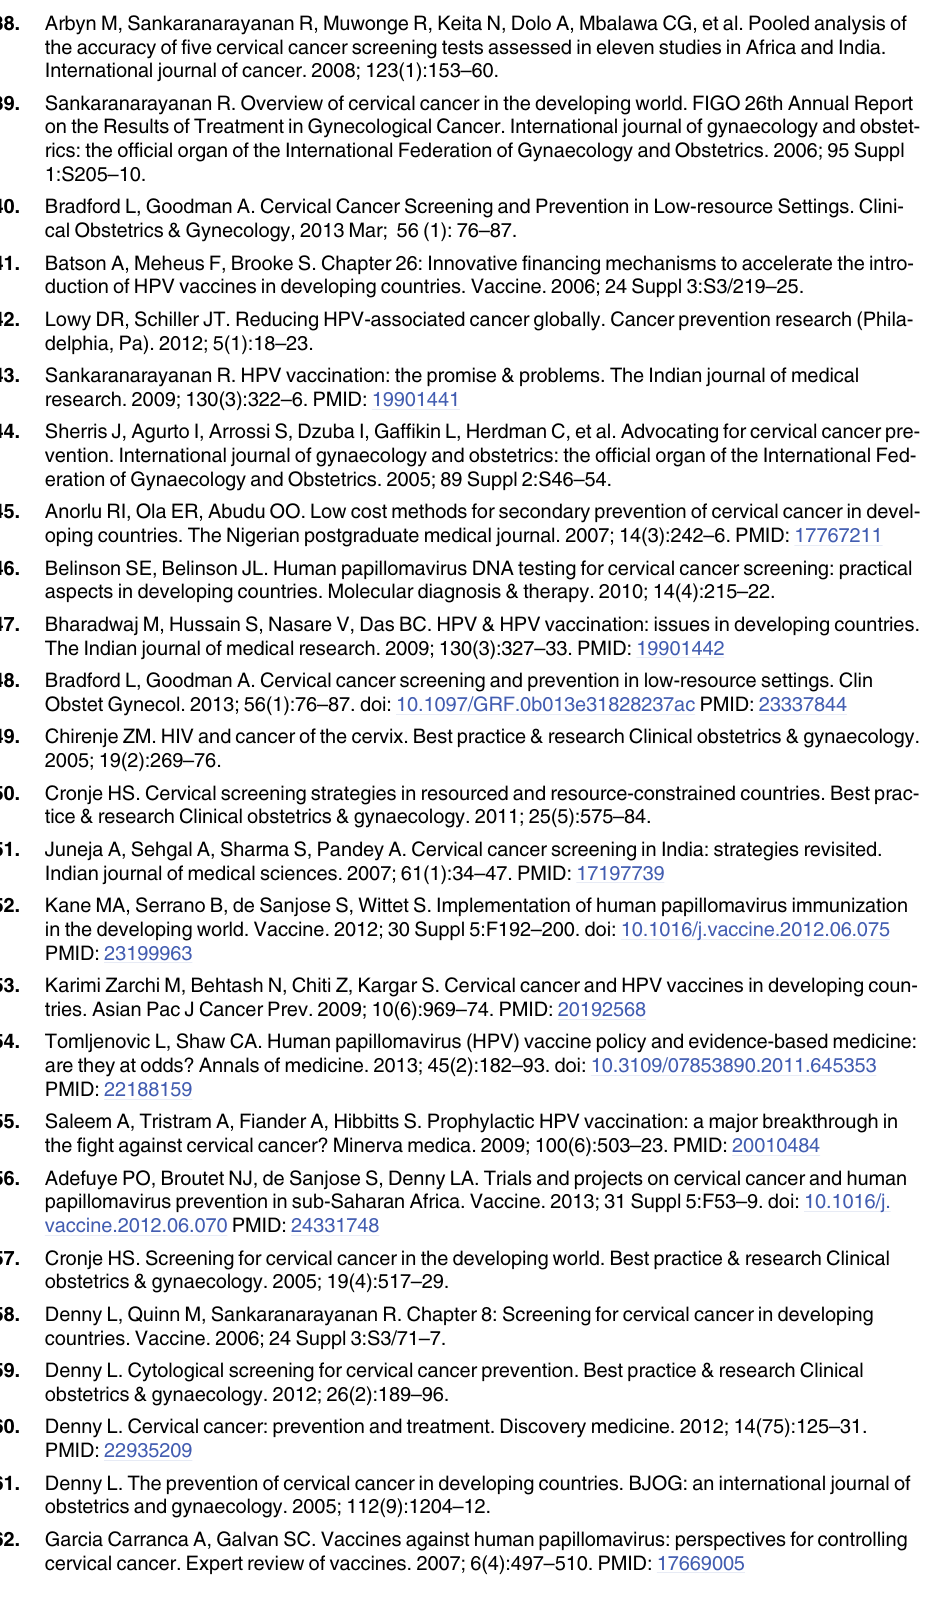
PLOS ONE | DOI:10.1371/journal.pone.0134618 September 1,